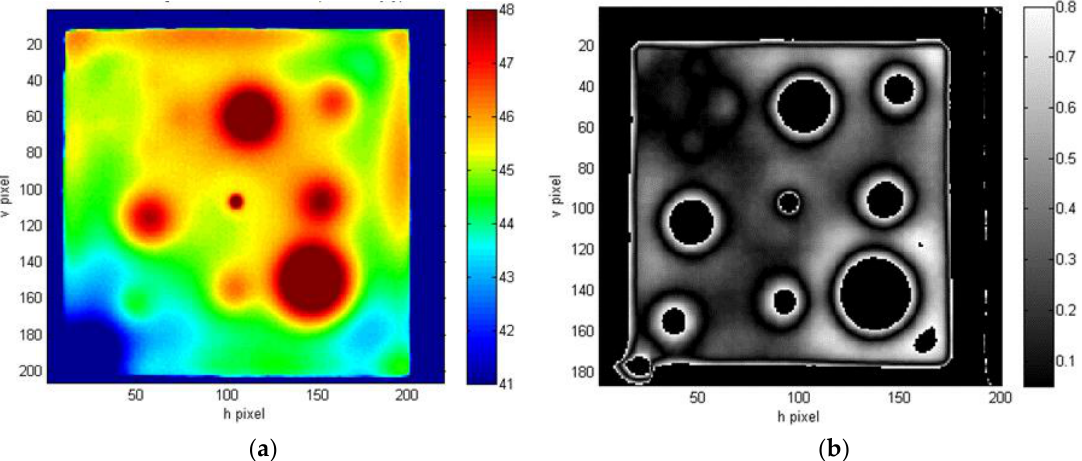
Figure 13. ( a ) Example of comparison between raw thermal map and ( b ) contrast map of CFRP Plate I/Side B.